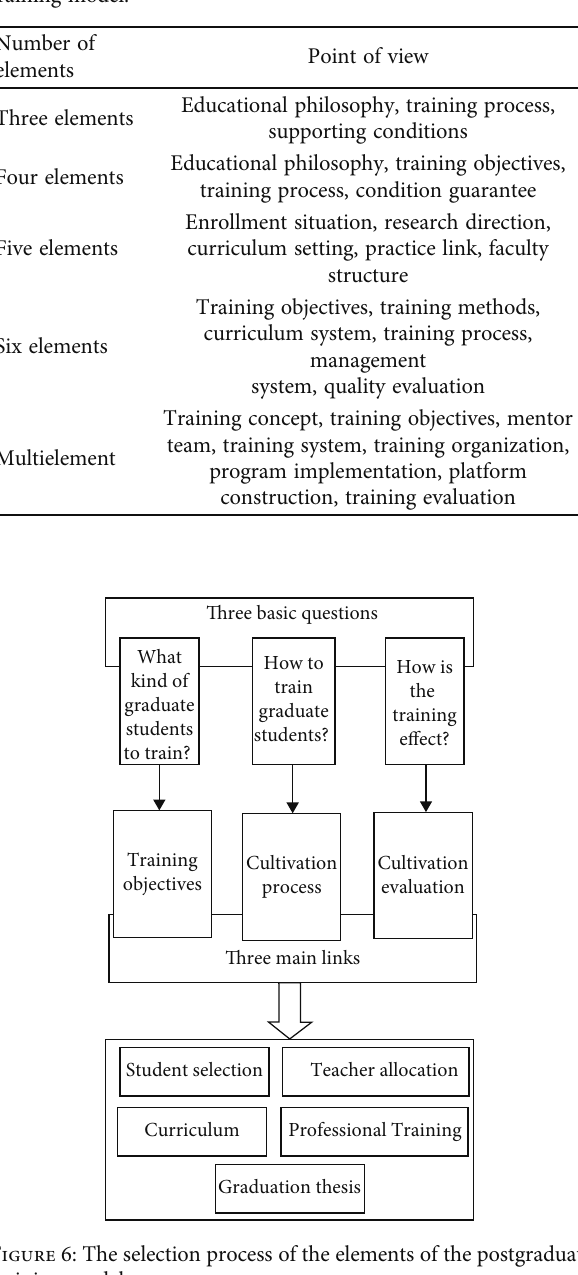
Table 1: Literature review of the elements of the postgraduate training model.